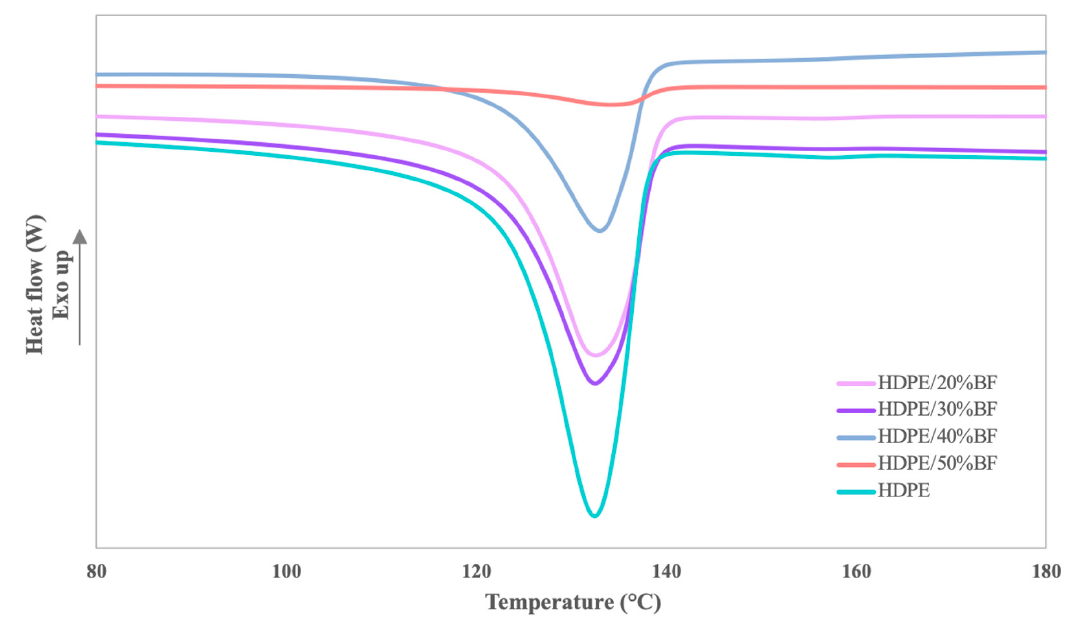
Figure 2. DSC thermographs of melting point of neat HDPE and 20 to 50 wt% BF-reinforced composite materials. Table 3. Thermal transition data of HDPE and HDPE/BF